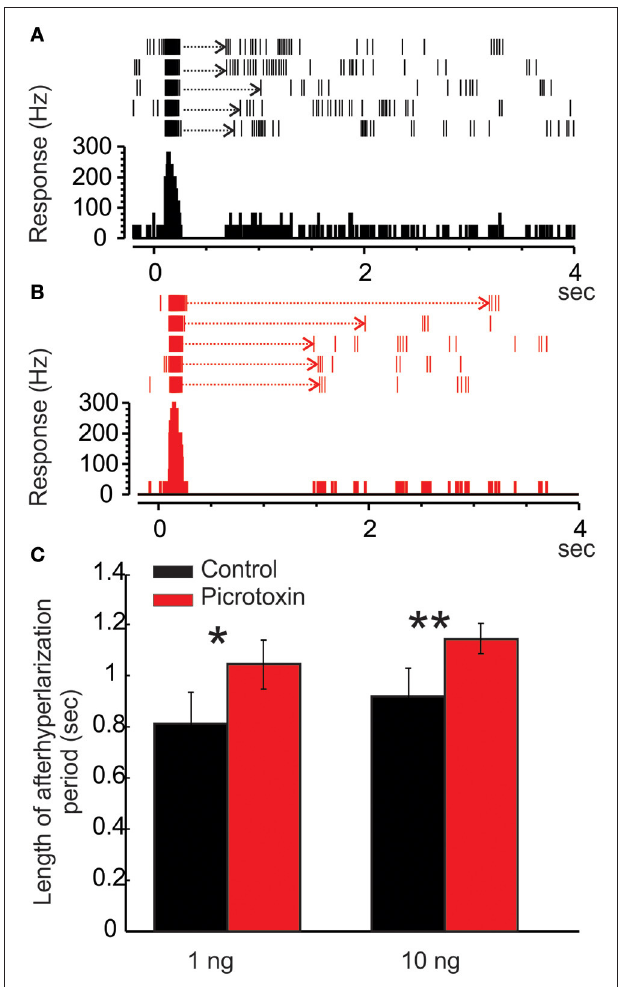
FIGURE 6 | Picrotoxin increases the duration of afterhyperpolarization (AHP). (A) Raster plot and peristimulus histogram show a typical excitatory response of a Toroid PN to five pulses of EZ stimulation. The stimulus onset is at time zero and lasts for 50ms. Note the AHP (dotted arrows) following the bursts of excitatory responses. (B) Under the picrotoxin treatment, the duration of AHP is significantly increased, along with a reduced spontaneous activity. (C) Group data showing that the picrotoxin-induced increase of AHP duration is statistically significant either under 1 or 10 ng stimulation ( Mann Whitney U -test, p < 0.05 or 0.01, n = 8 ; asterisks indicate the significance level).